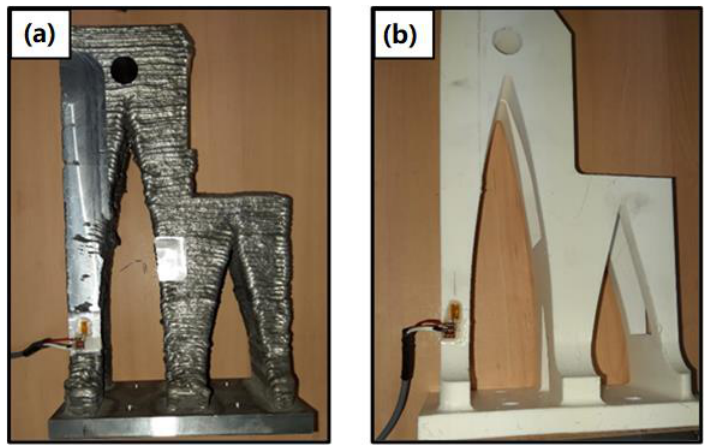
Figure 11. The strain gauge is placed on one of the legs of the parts to be tested: ( a ) WAAM AA53536 and ( b ) PLA parts.